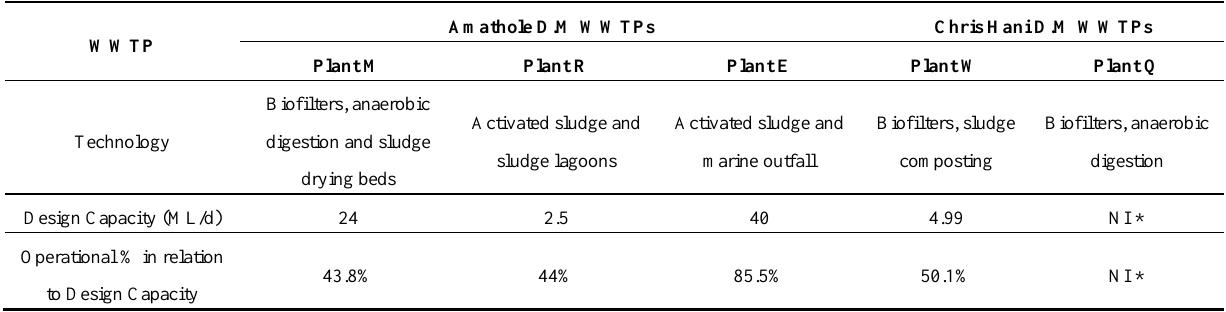
Table 1. Some characteristics of the